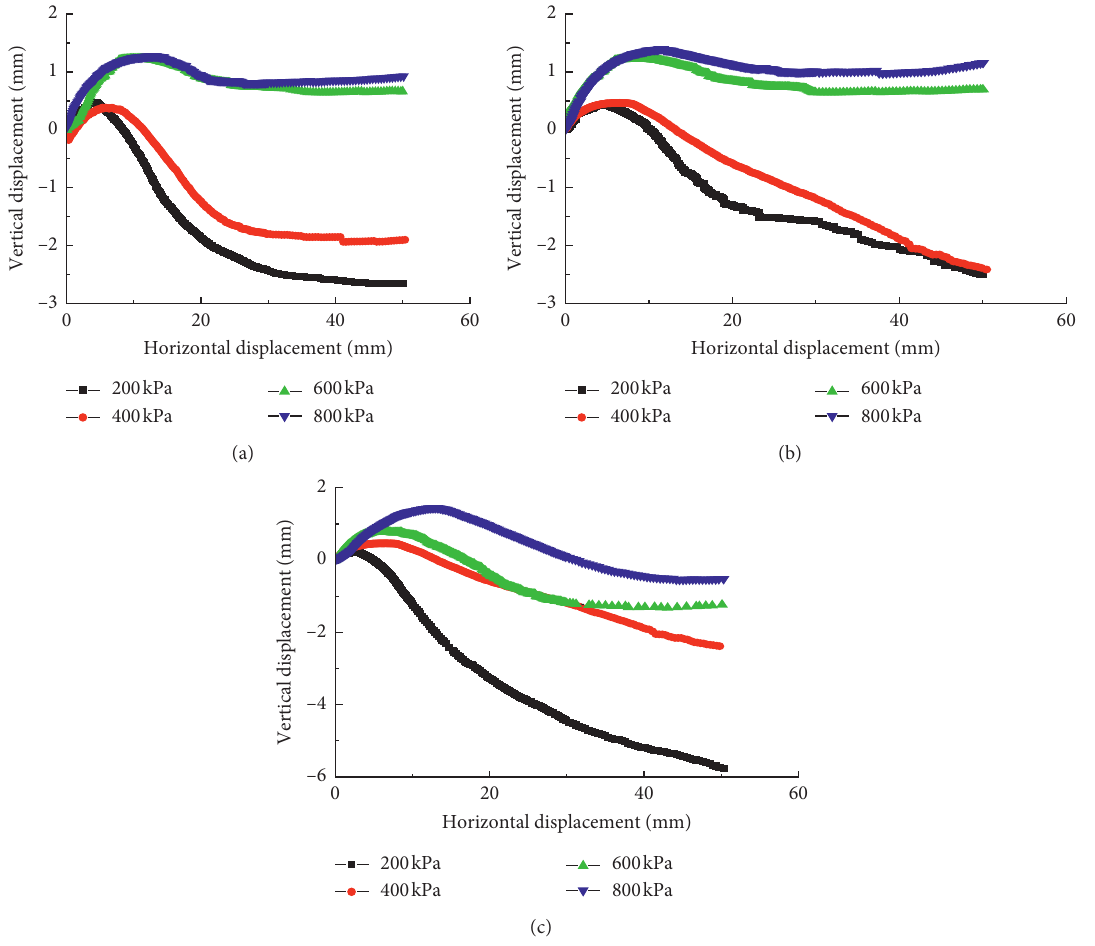
Figure 6: Vertical displacement vs horizontal displacement curves of S-RMs with different maximum particle diameters. (a) 40mm. (b) 60mm. (c)